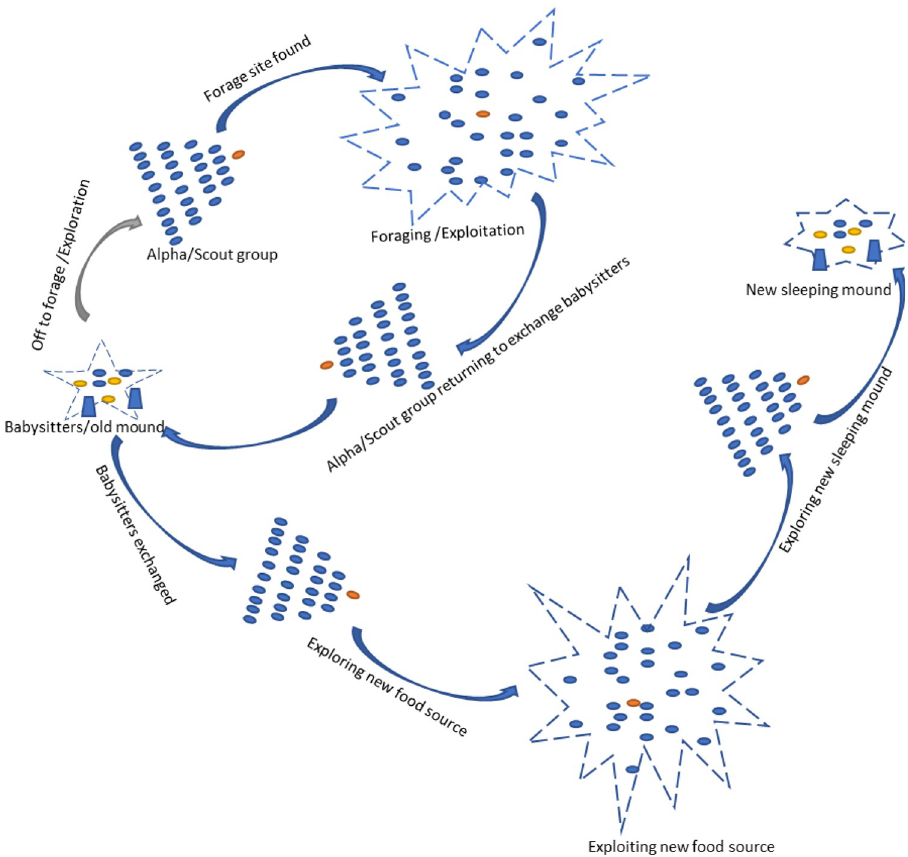
Fig 1. The optimization procedures of the